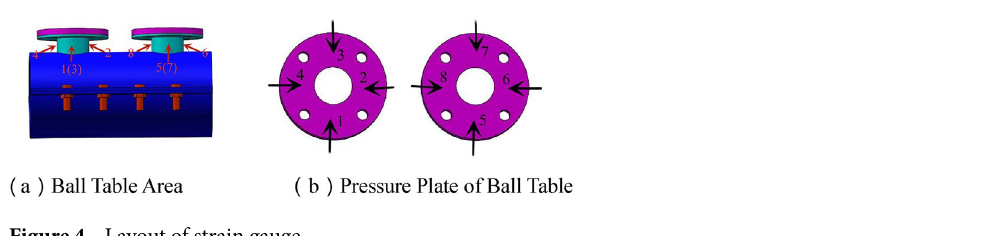
Figure 4. Layout of strain